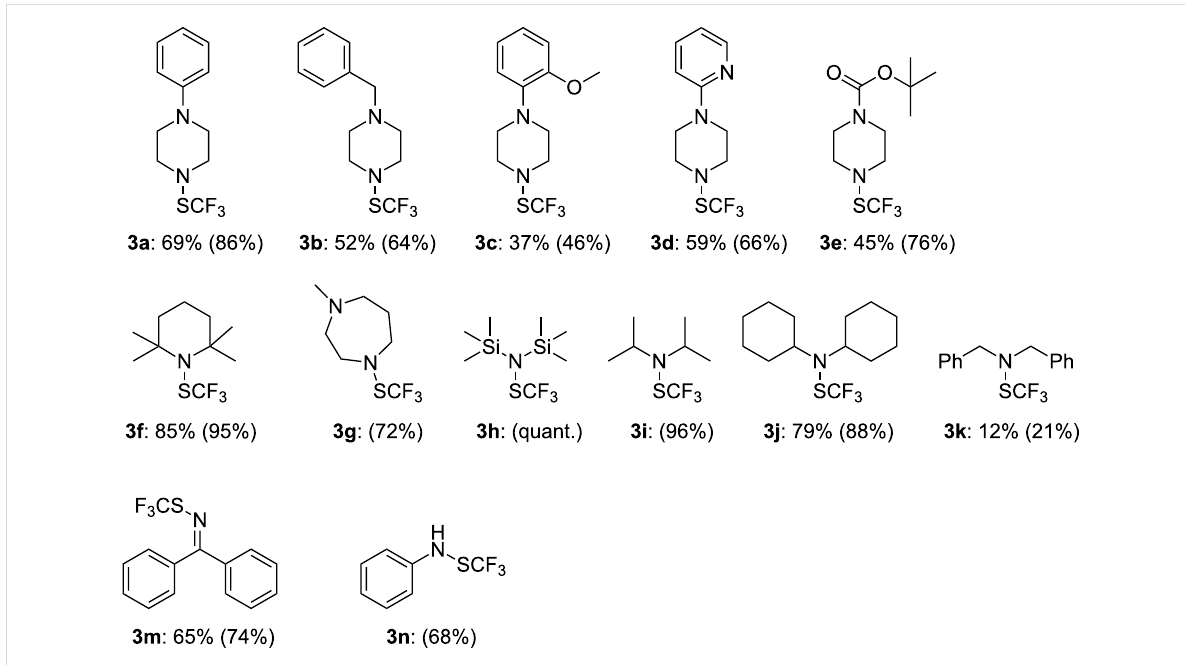
Figure 1: Transamination of 1a with amines. (Isolated yields, in parentheses crude yields determined by 19 F NMR with PhOCF 3 as an internal stan- dard).